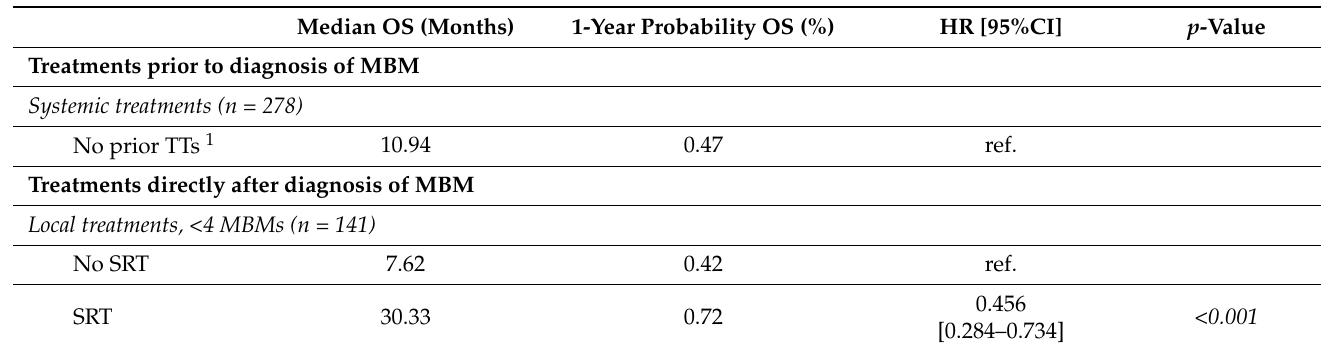
Table A4. Overall survival (OS) for treatment subgroups of patients with melanoma brain metastasis (MBM) in the post-2015 cohort ( n = 278) and for local treatments in the post-2015 cohort of patients with <4 MBMs ( n =